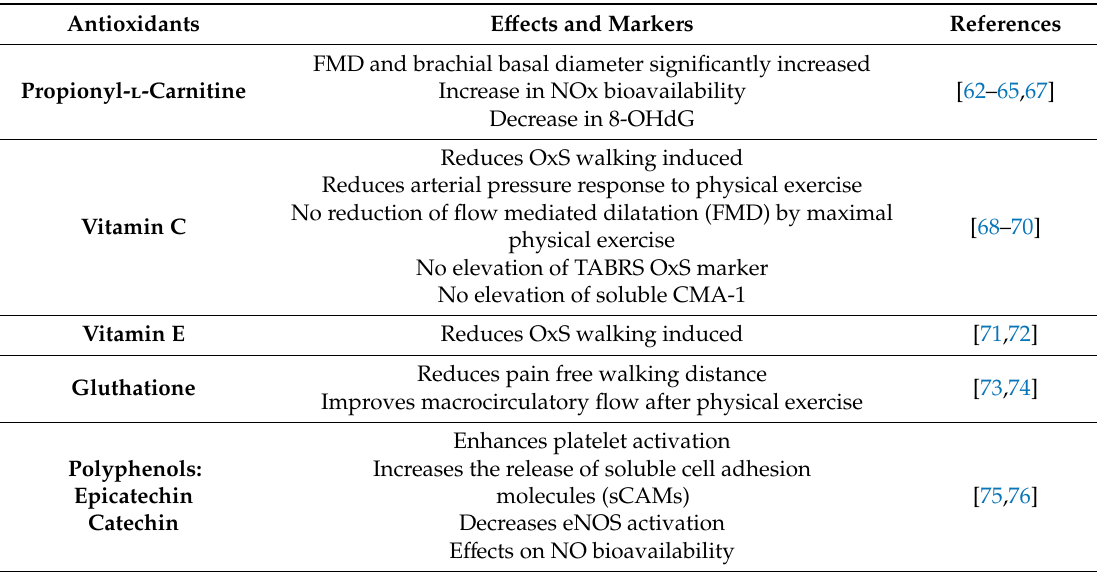
Table 1. The below table summarizes data from studies focused on e ff ect of antioxidant supplementation in